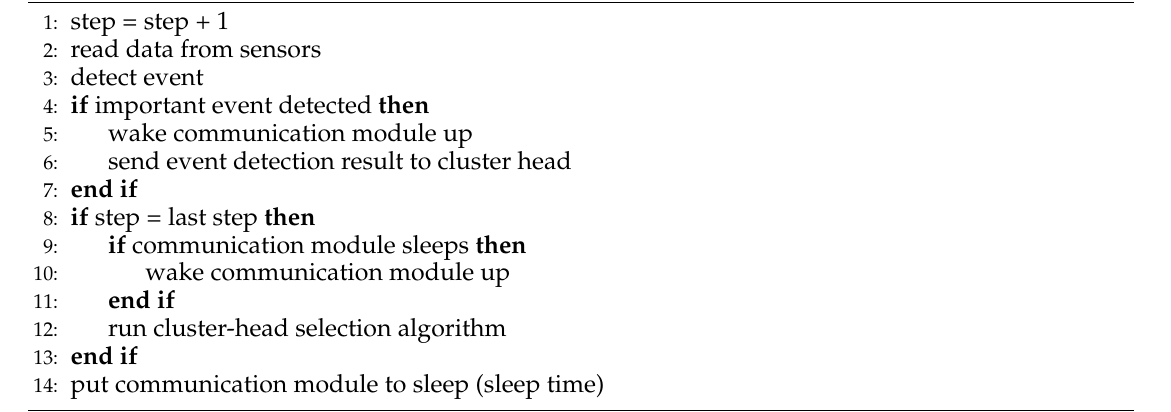
Algorithm 1 Node operating in cluster member mode